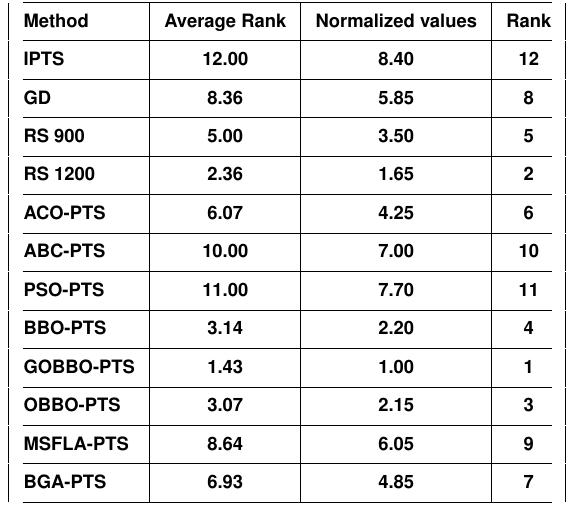
Table 6. Average Rankings achieved by Friedman